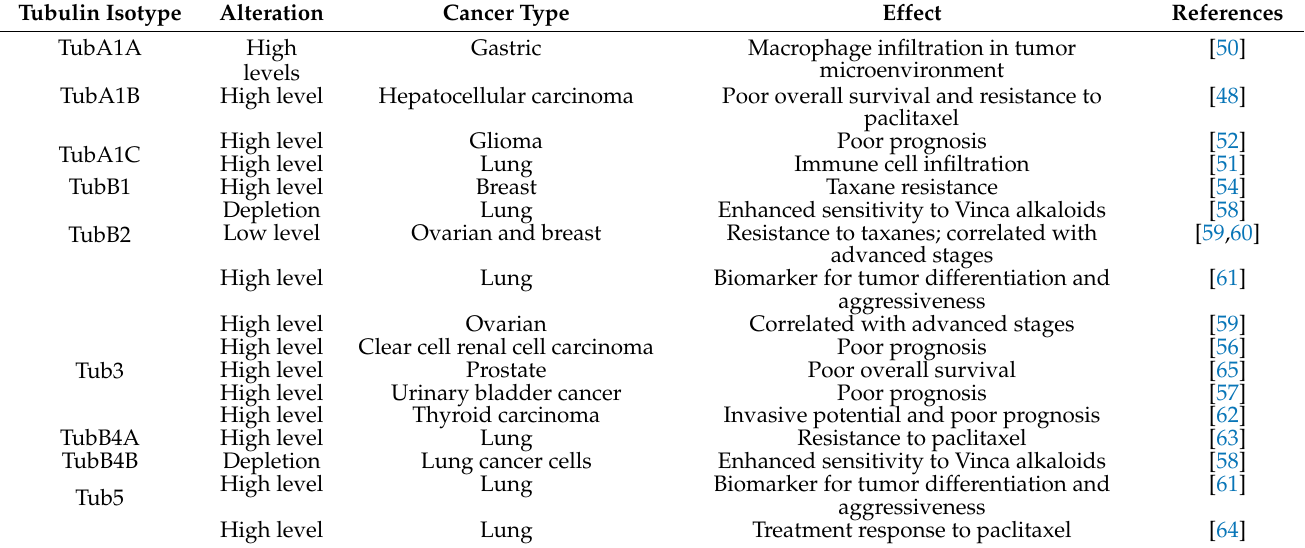
Table 2. Significance of aberrant expression of tubulin isotypes in